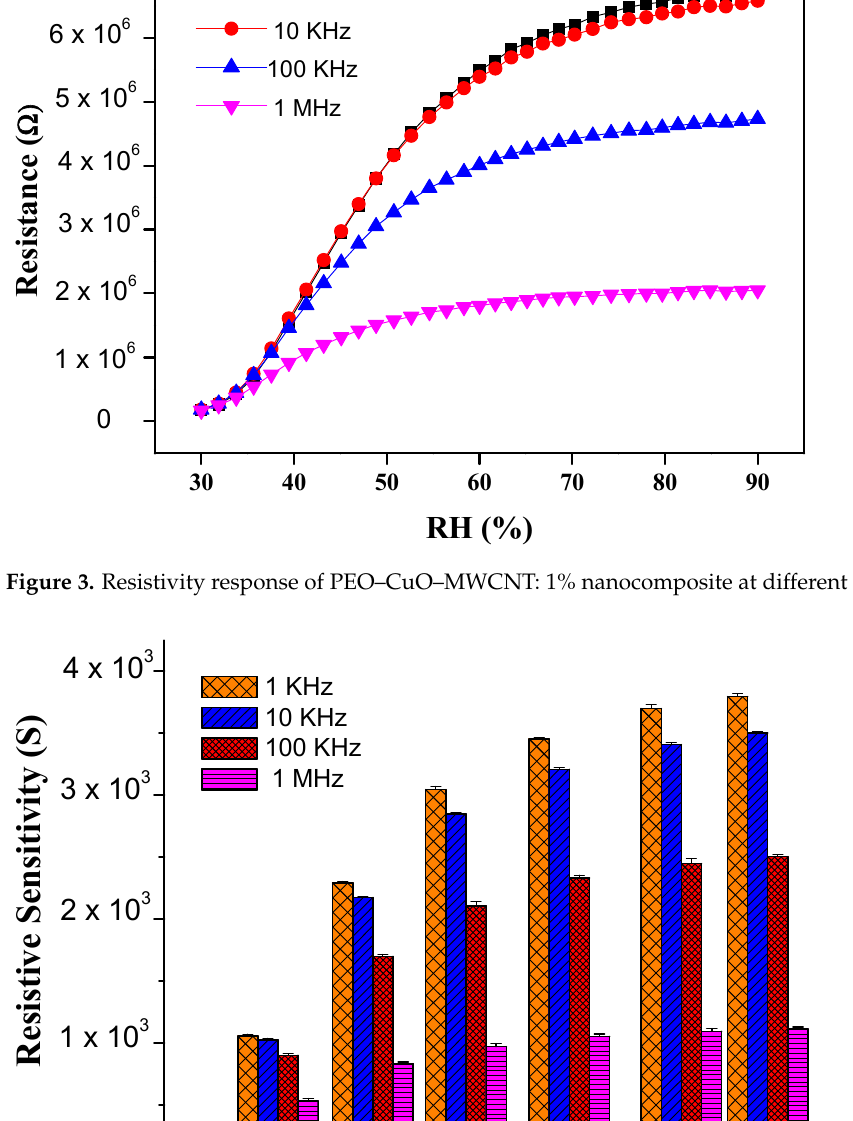
Figure 5. Resistive linearity of PEO − CuO − MWCNT: 1% nanocomposites.